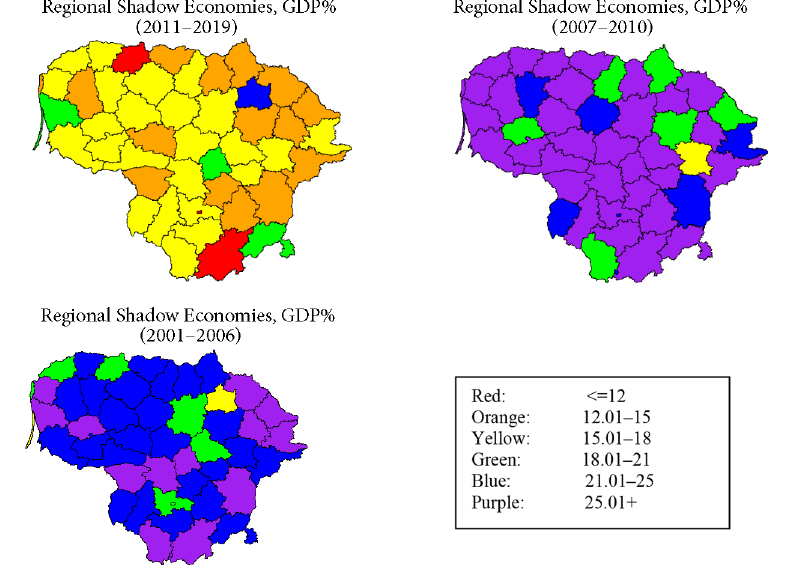
Figure 1. Maps of the regional shadow economies for three periods (own